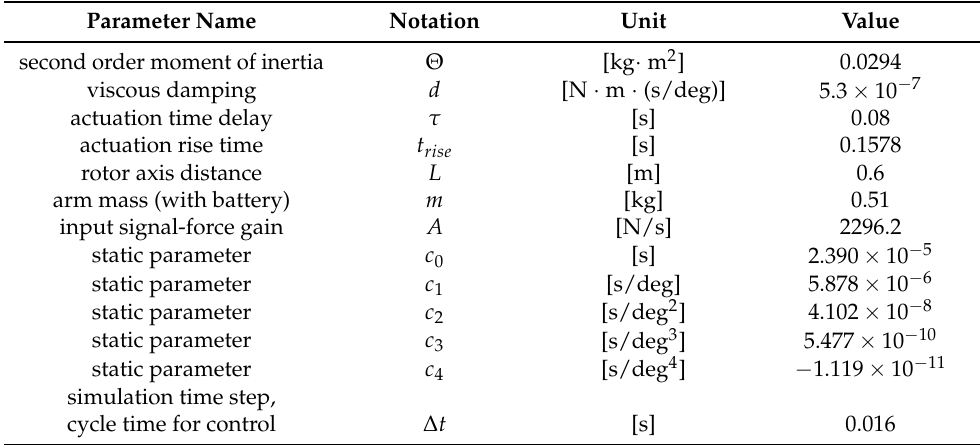
Table 2. Values, names, and units of identified model